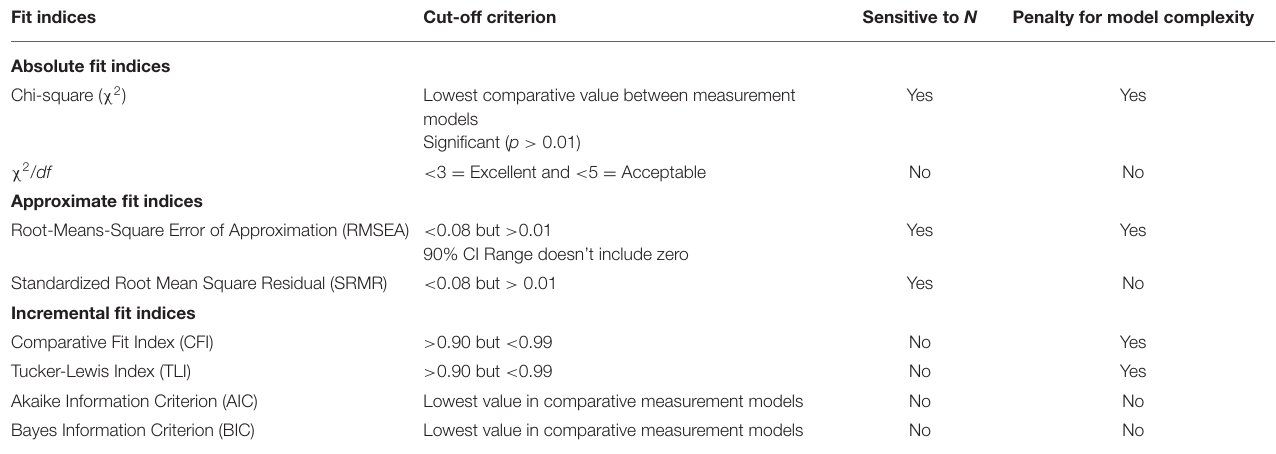
TABLE 2 | Model fit